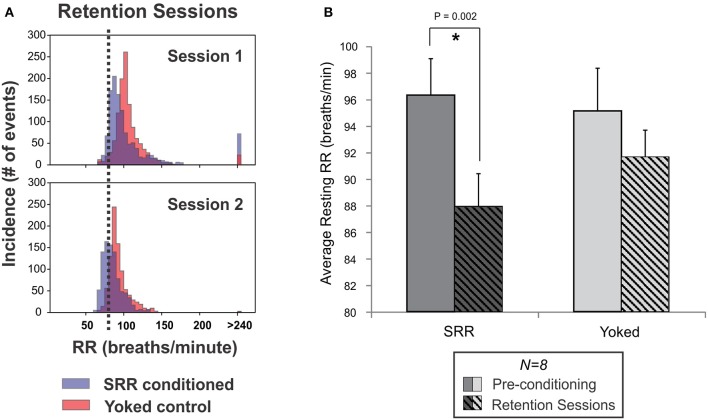
Reduced RR was retained between SRR conditioning sessions. (A) Individual frequency histograms for one pair of SRR conditioned (blue) and yoked control (red) rats during two representative retention sessions. These 2 h sessions were interspersed with normal conditioning and 4 days apart from one another (following Sessions 7 and 10, respectively). The RR threshold for conditioning (80 breaths/min) is shown with vertical black dotted lines. (B) Pooled results for all animals and retention sessions. SRR conditioned rats maintained trained reductions in RR during SRR retention sessions (*p < 0.05, paired t-test). Values averaged across SRR retention sessions were 87.9 ± 2.5 breaths/min for SRR conditioned rats (pre-conditioning: 96.3 ± 2.7 breaths/min) and 91.6 ± 2.0 breaths/min for yoked controls (pre-conditioning: 95.1 ± 3.2 breaths/min).